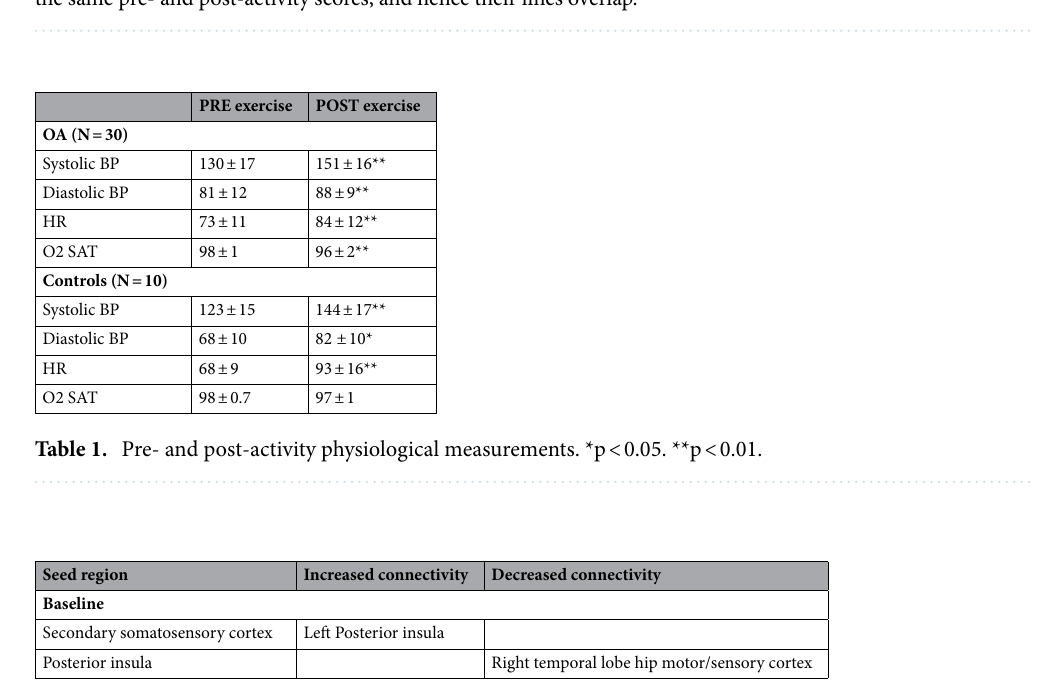
Figure 1. VAS scores for all hip OA patients (n = 30) before and after physical activity. Several patients exhibited the same pre- and post-activity scores, and hence their lines overlap.